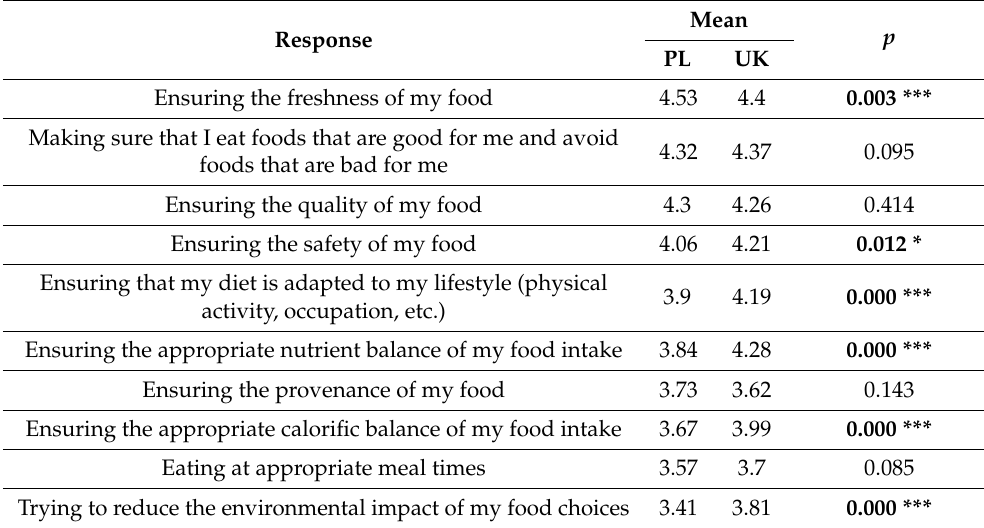
Table 2. The meaning of the term “healthy eating” in the surveyed groups—averages and p -values in the Mann–Whitney U test for the differences between respondents from PL and the UK.